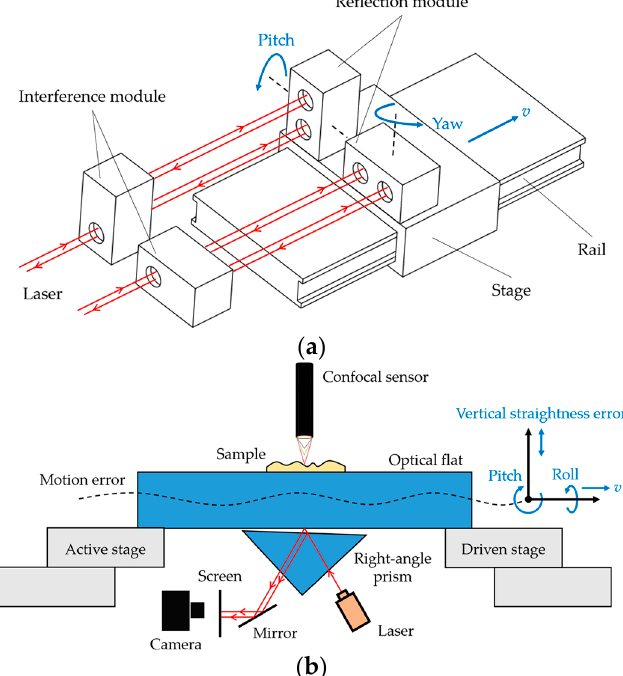
Figure 1. Comparison between the traditional laser interferometer and the film interferometer: ( a ) degree of freedom measured by the traditional laser interferometer; ( b ) degree of freedom measured by the film interferometer.